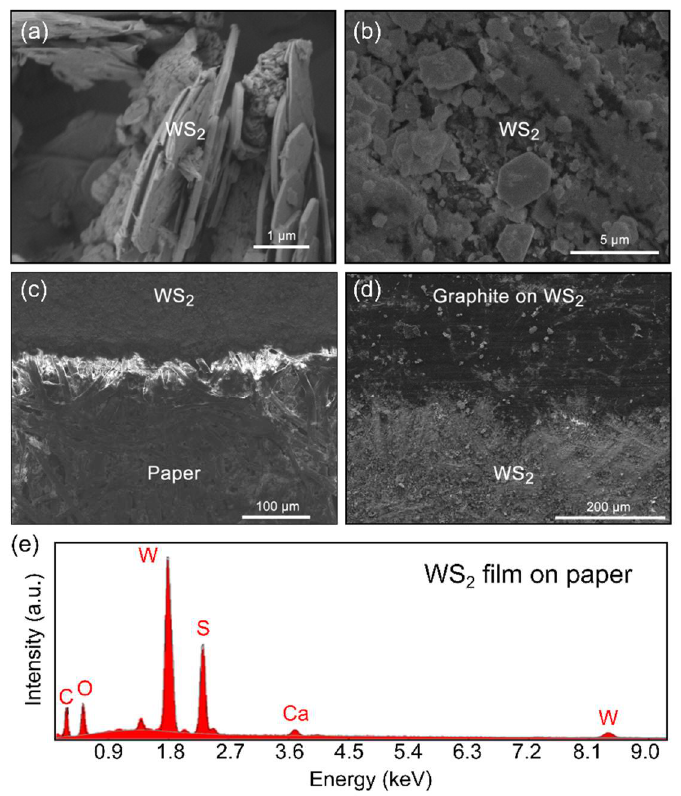
Figure 3. SEM images of ( a ) the cross-section of the WS 2 flakes deposited on paper by abrasion technique, ( b ) the network of WS 2 flakes deposited on paper after abrasion-induced deposition, ( c ) the interface between bare paper and the deposited WS 2 film, and ( d ) the border between the surface of the WS 2 sensing area and the WS 2 covered by the graphite electrode. ( e ) EDX spectrum for the micronized WS 2 deposited on the paper.